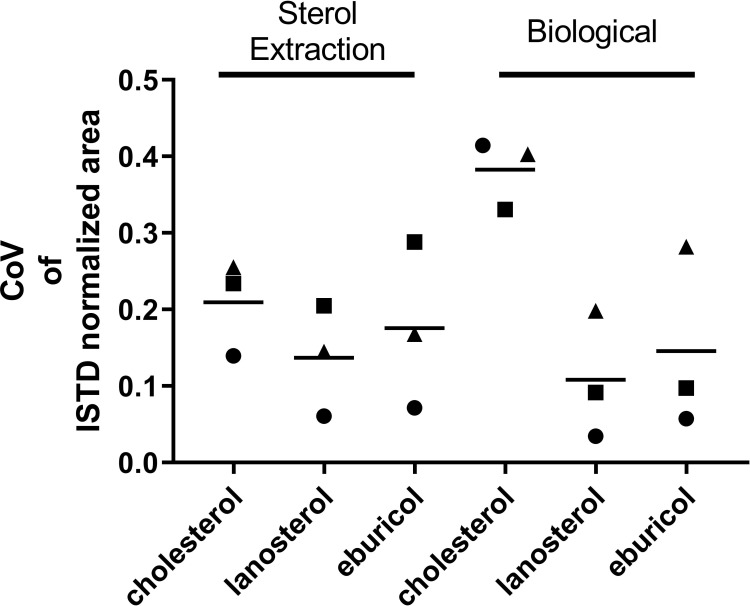
Endogenous lanosterol and eburicol but not host derived cholesterol are reliable quantifiable from isolated intracellular amastigotes.Isolated amastigotes (52 hpi) were prepared on three independent occasions (biological) and each isolation was extracted three separate times (sterol extraction). The coefficient of variation of standard normalized area (GC-MS) was determined, means indicated. Variation in cholesterol between biological replicates prohibits reliable quantification.